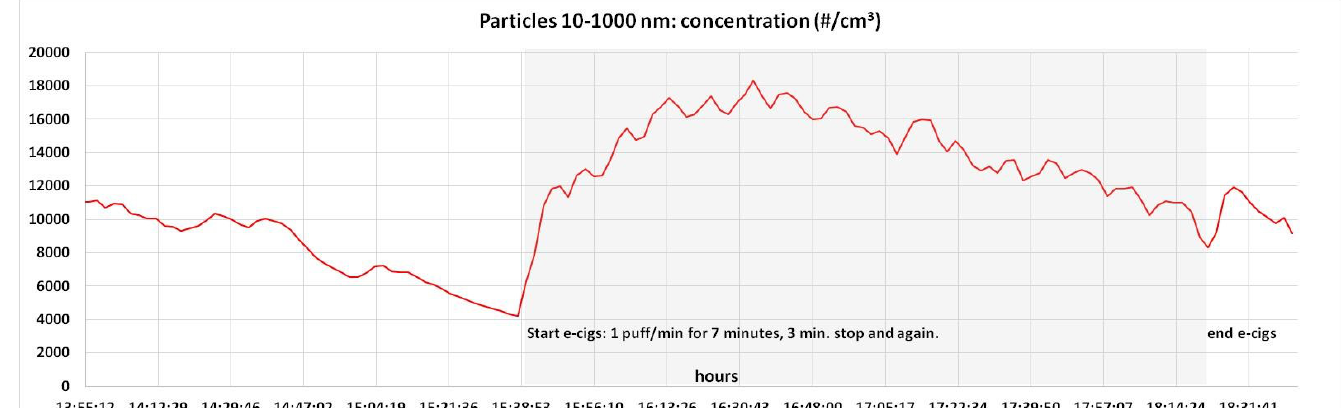
Figure 3. Real- time graph of ECSHA using “Elips C” ECs measur ed in counts/cm 3 , with a sampling Figure 3. Real-time graph of ECSHA using “Elips C” ECs measured in counts/cm 3 , with a sampling time of 2 min. time of 2 min.